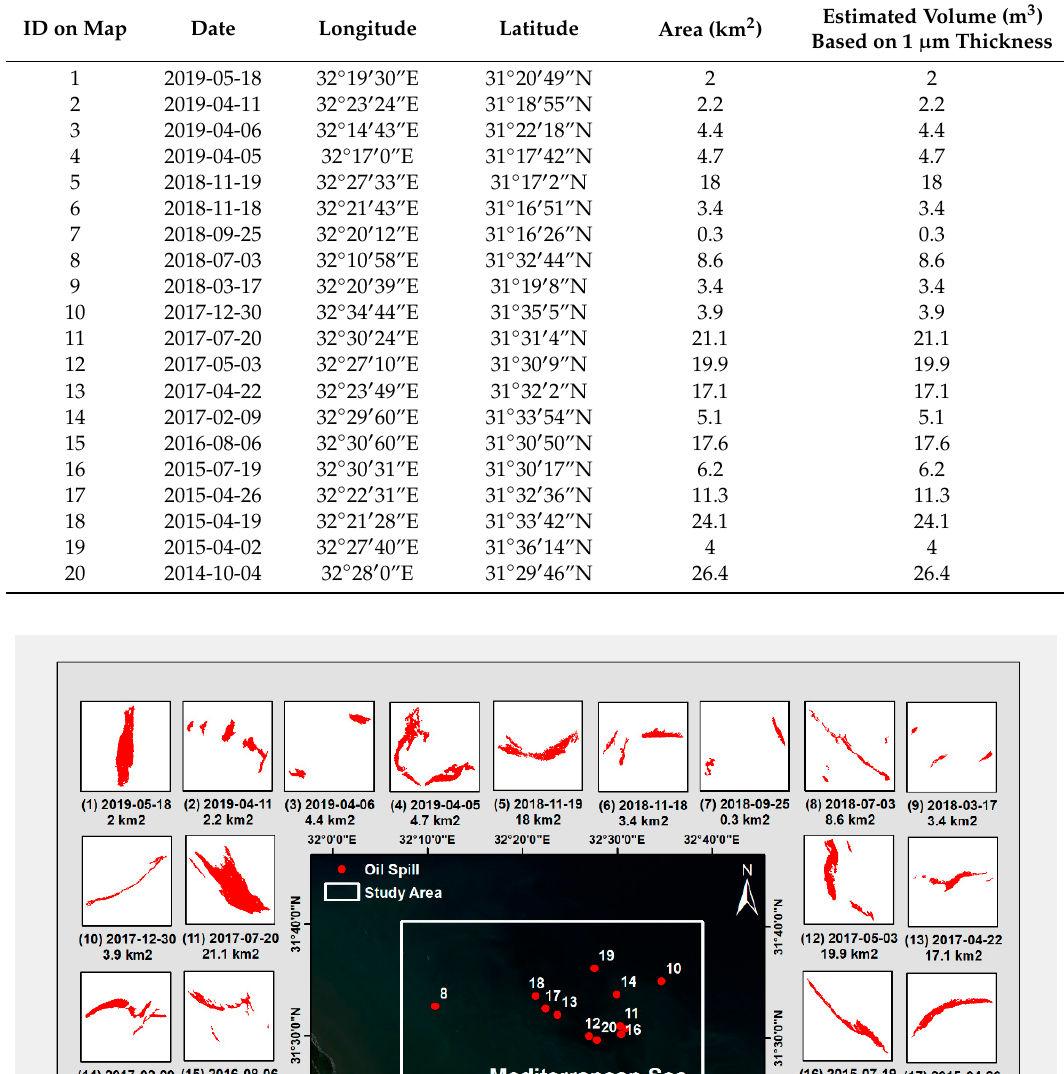
Table 2. Statistics of oil spill events within the period 2014–2019.